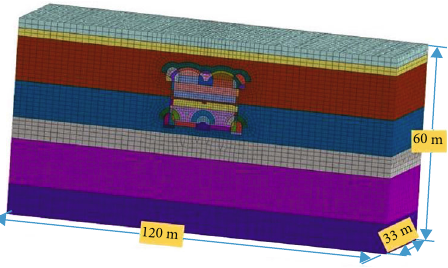
Figure 4: 3D numerical